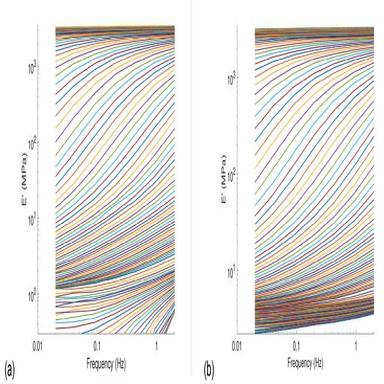
Isotherms from the DMA results for (a) F-NR2, (b) F-NR3.